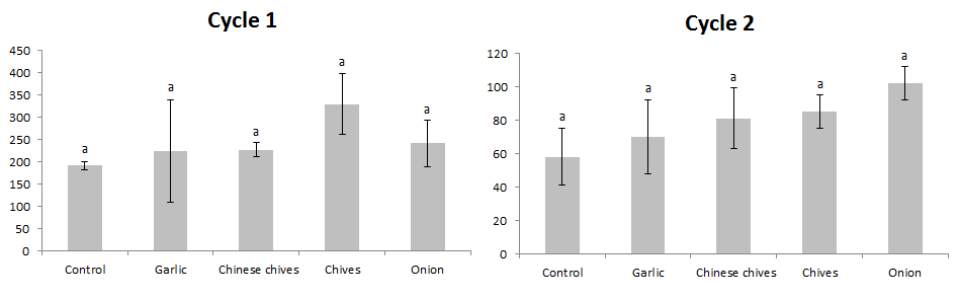
Figure 5. Mean total pseudofruit production (g) (± Standard deviation) of each strawberry plant under Amaryllidaceae plants ’ intercropping, in two crop cycles. Londrina, Paraná, Brazil, October 2016 to November 2017. Bars followed by the same letter are not significantly different by Tukey test ( p > 0.05).